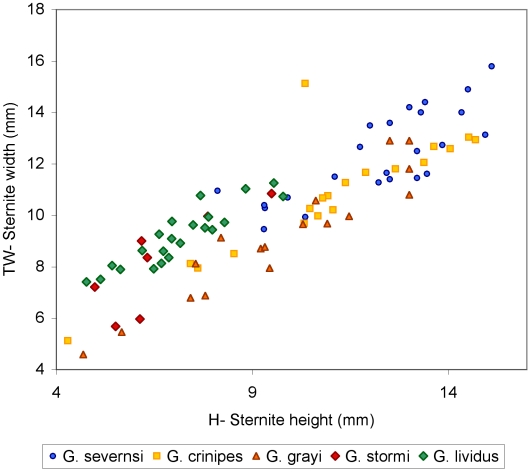
Anterior width (TW) vs. height (H) of 4th sternite in mm.